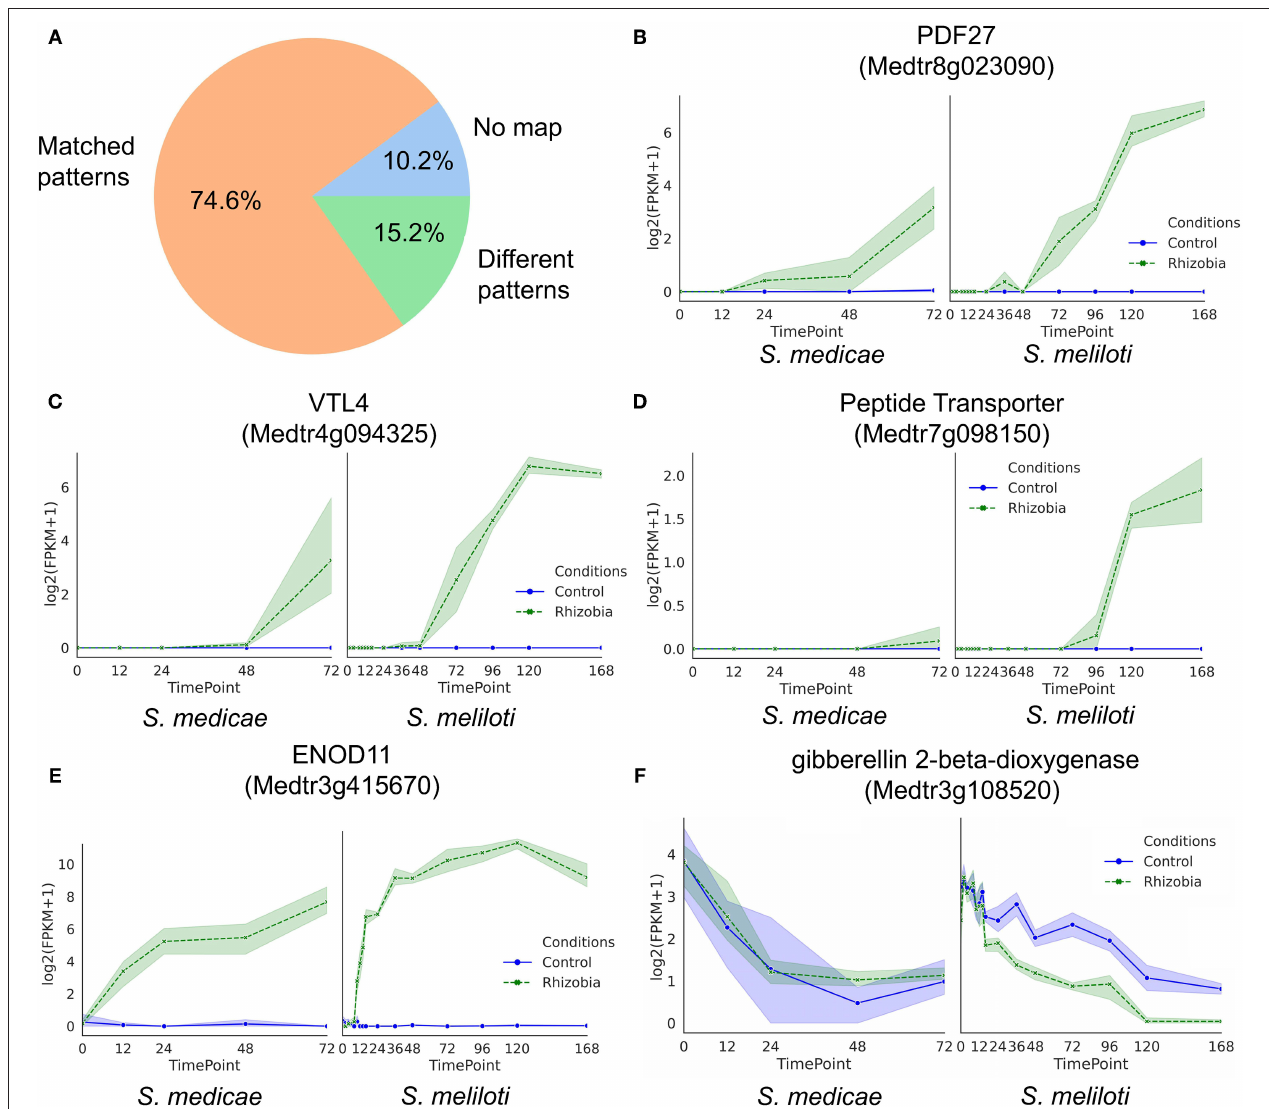
FIGURE 5 | Validation of root time-series expression profiles detected by GeneShift (A) Pie chart of GeneShift detected 118 time-series root DEGs expression profiles from our Sinorhizobium medicae inoculation M.truncatula experiment in comparison to previously published S. meliloti induced M.truncatula transcriptomic data. (B–F) Expression profiles of representative genes in our study S. medicae vs. Schiessl study S.meliloti . Y-axis, log2 (FPKM+1); x-axis, time (h) after rhizobia inoculation, each dot represents mean value of replicates, and shading indicates confidence